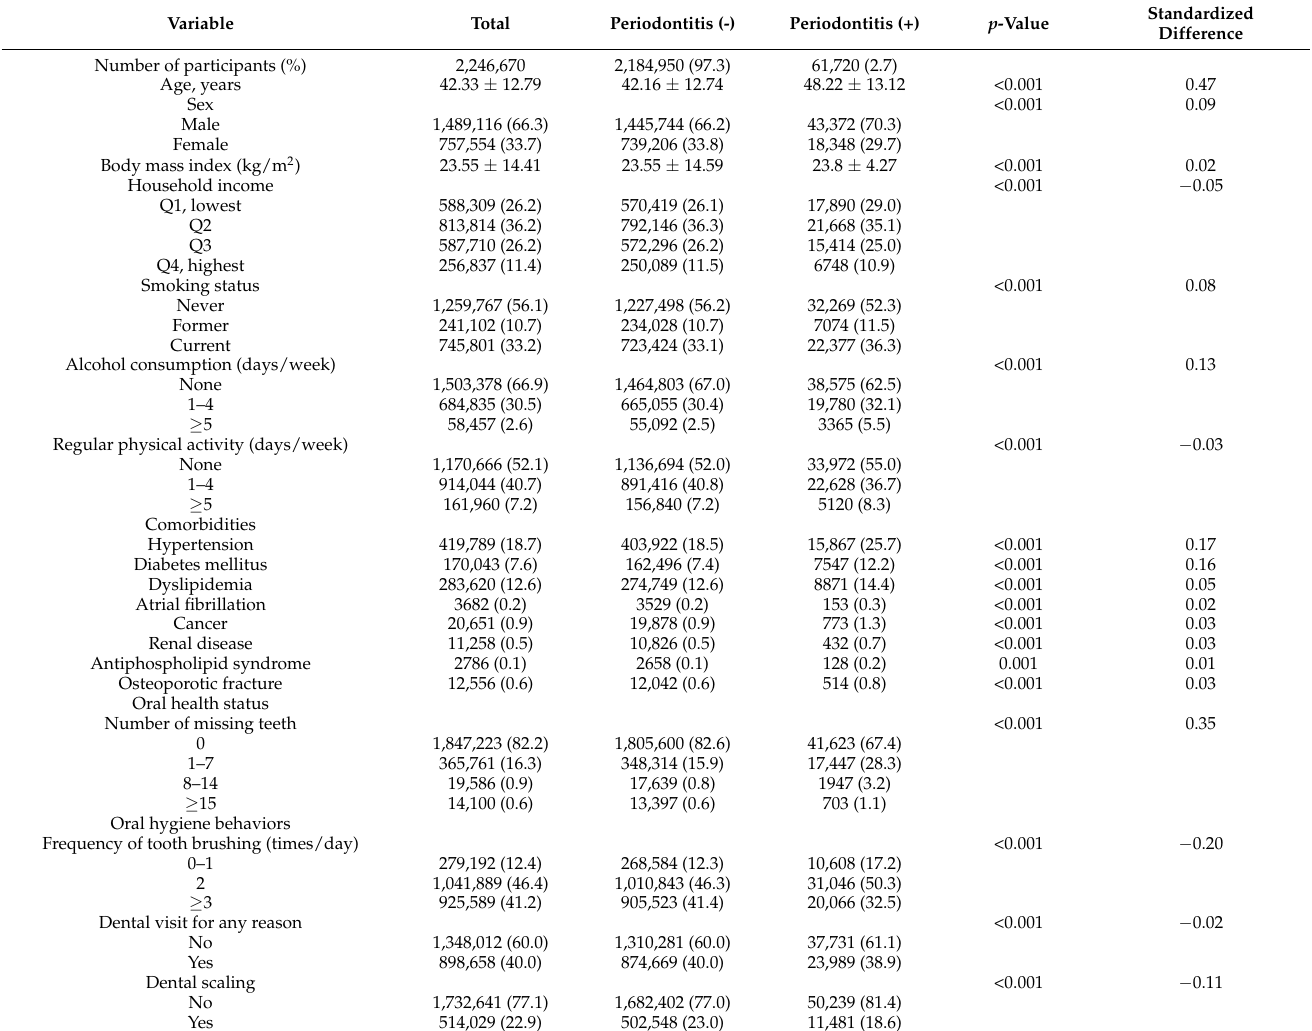
Table 1. Baseline characteristics of subjects according to the presence of